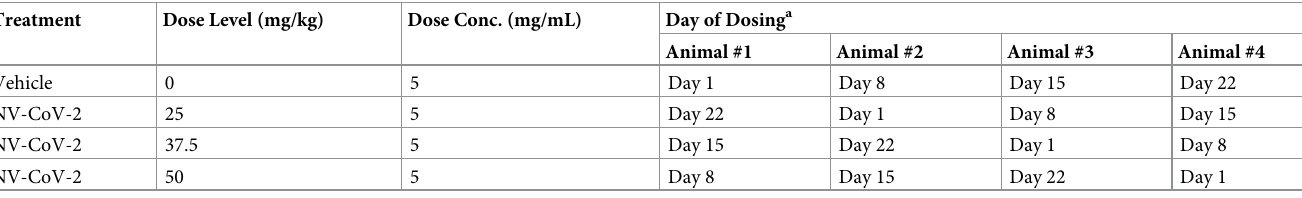
Table 3. The test article administration schedule (Latin square